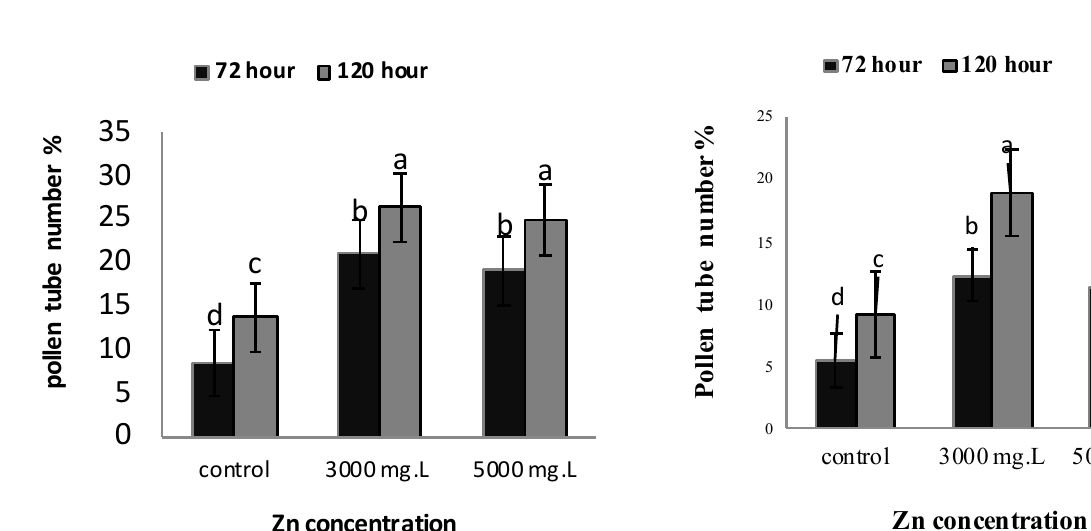
Fig. 6. The interactions between time and Zn concentration on the pollen germination percentage on the stigma. Means in each col- umn, followed by similar letter (s) are not significantly different at 1% probability level.